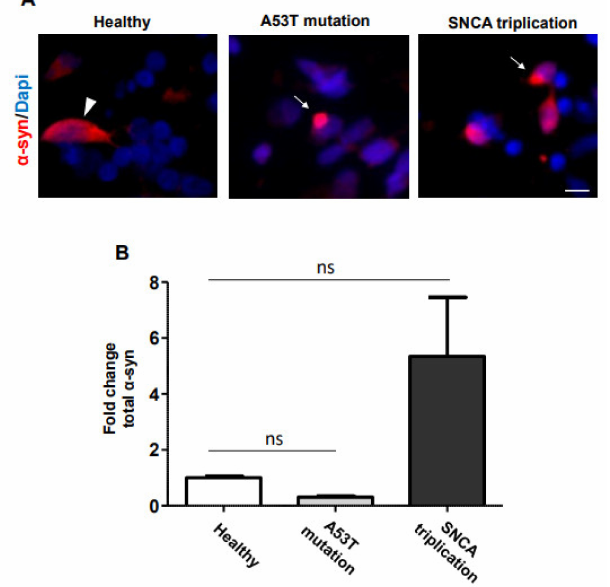
Figure 3. α -syn accumulation in mDA neuronal cultures from fPD patients. ( A ) Seventy-day-old mDA neuronal cultures, from healthy and familial PD lines, were stained with an anti- α -syn antibody. α -syn accumulation around the nucleus in the A53T mutation and SNCA triplication line is indicated by arrows, whereas the homogenous distribution of native α -syn immunostaining in the healthy line is indicated by the arrowhead. ( B ) The level of α -syn immunostaining was quantified using image analysis. Images are representative of at least three independent differentiations. All data in ( B ) are presented as mean ± SEM of three images acquired from three different coverslips. Data were analyzed by one-way ANOVA followed by Tukey’s multiple comparison post hoc test. * p < 0.05. The scale bar is 10 µ